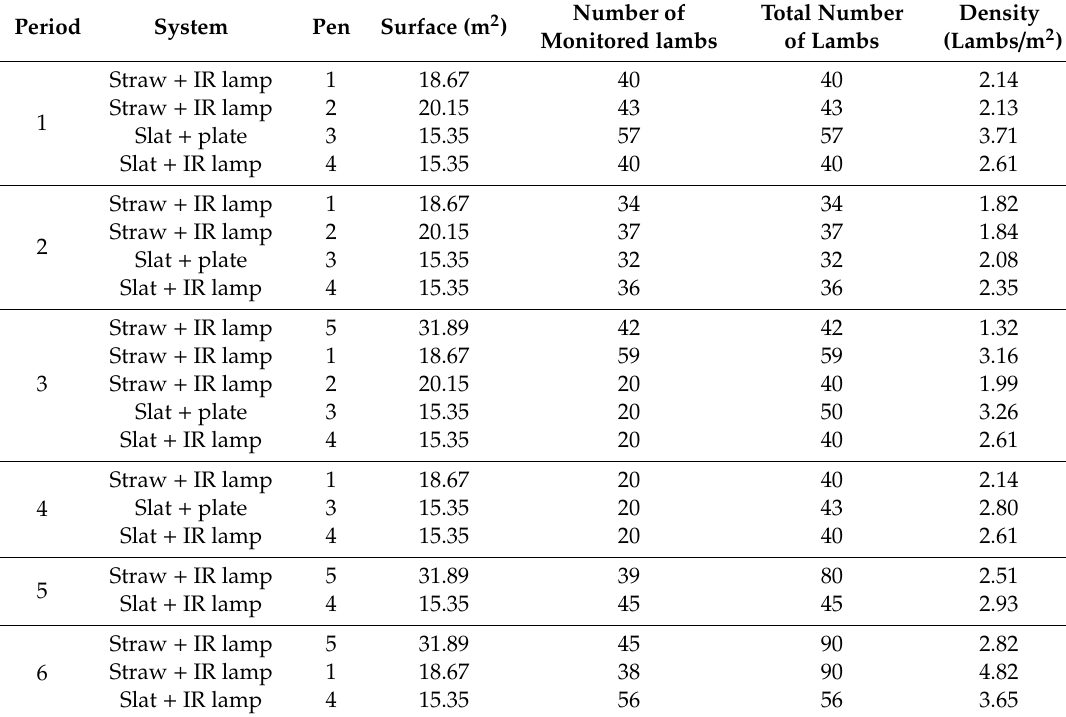
Table 1. Distribution of the lambs into pens for the di ff erent periods of